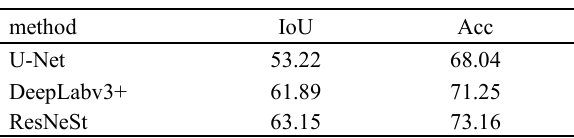
Table 2 . A comparison of our method with other method on Deepglobe data